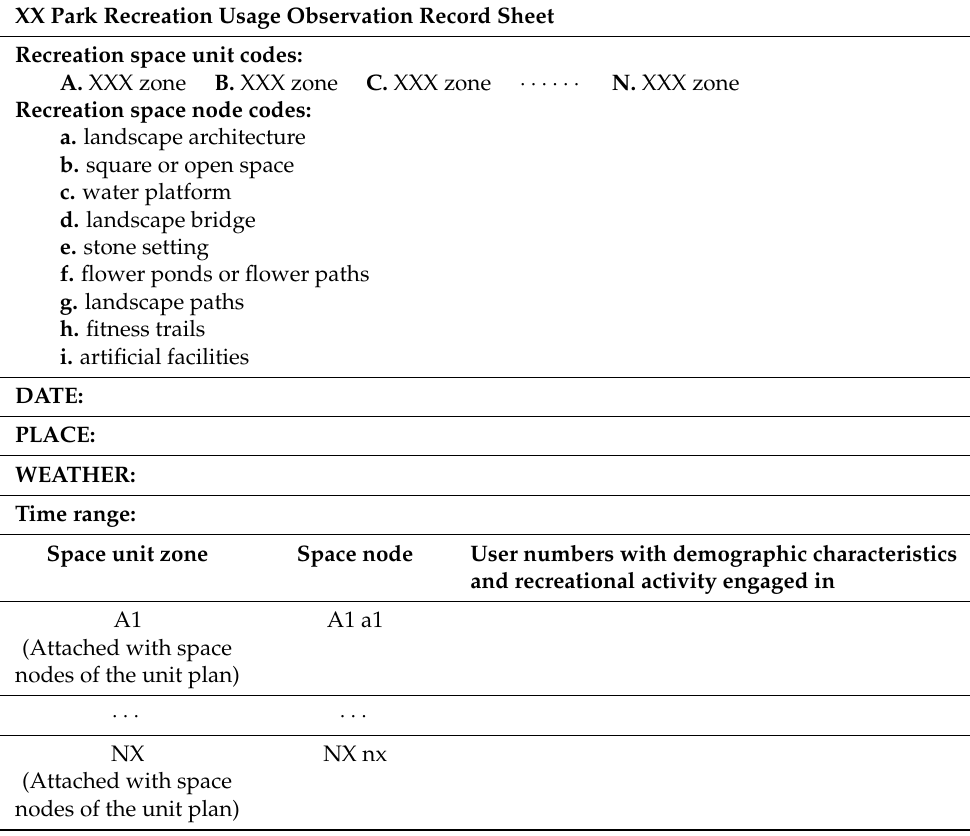
Table A1. Urban park recreation usage observation record sheet